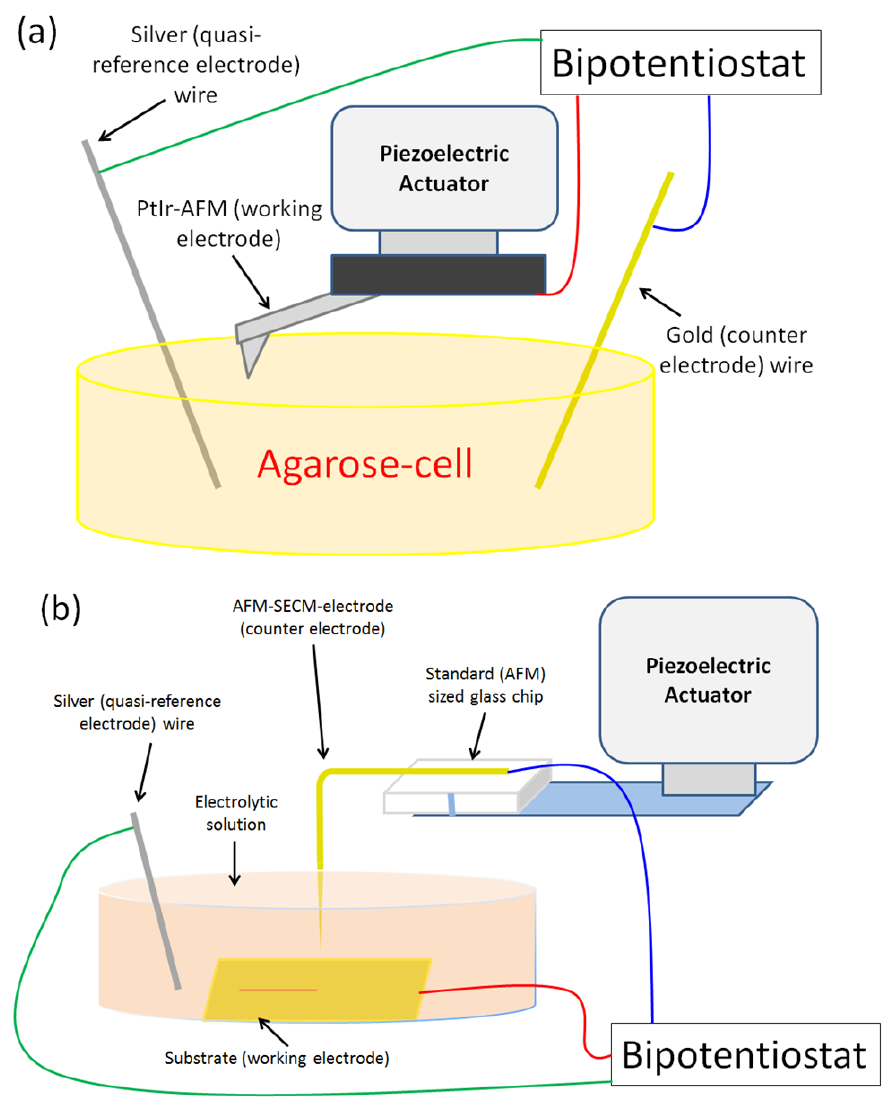
Figure 3. Schematic drawing of AFM setups ( a ) for the AFM-SECM/Agarose system; ( b ) for the nano-electrografting